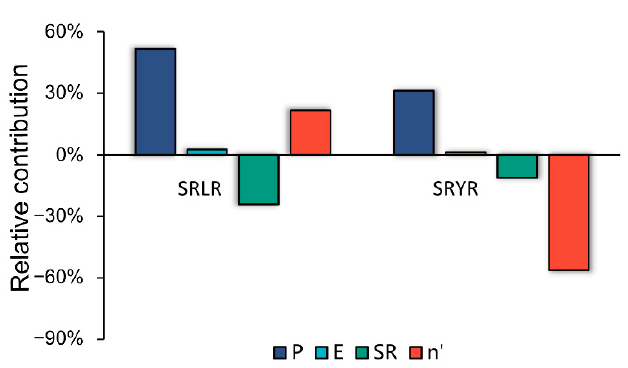
Figure 9. Contribution of each factor to changes in basin runoff.